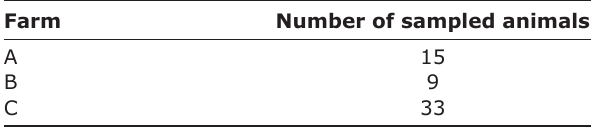
Table-1: Number of animals sampled in each farm.